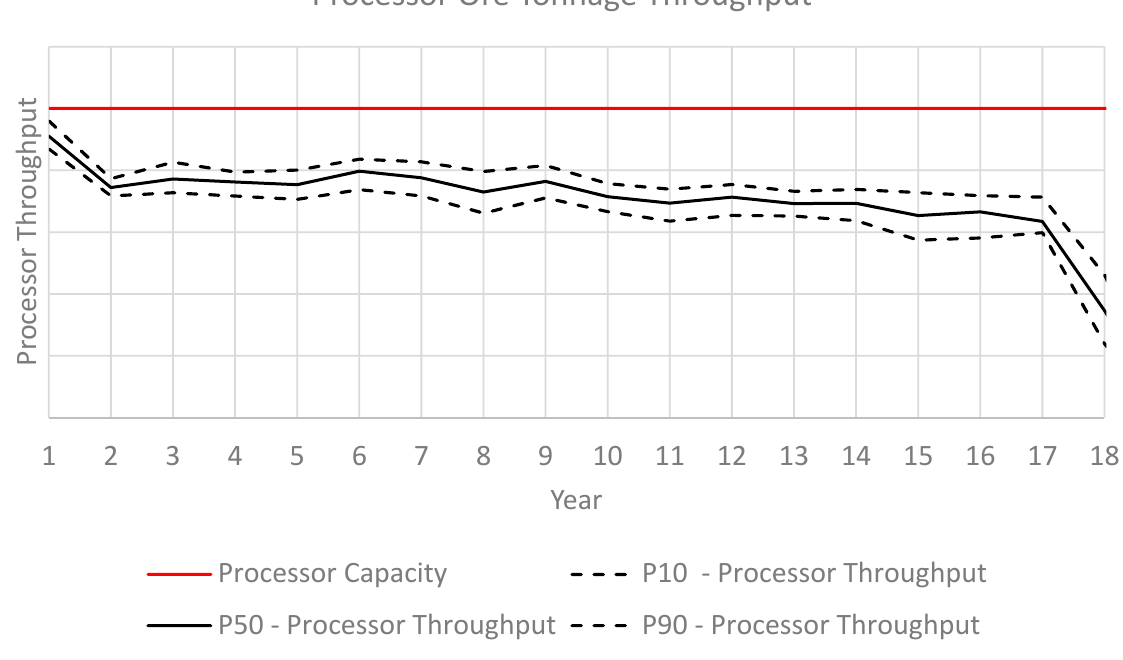
Figure 11. Processor ore tonnage throughput.